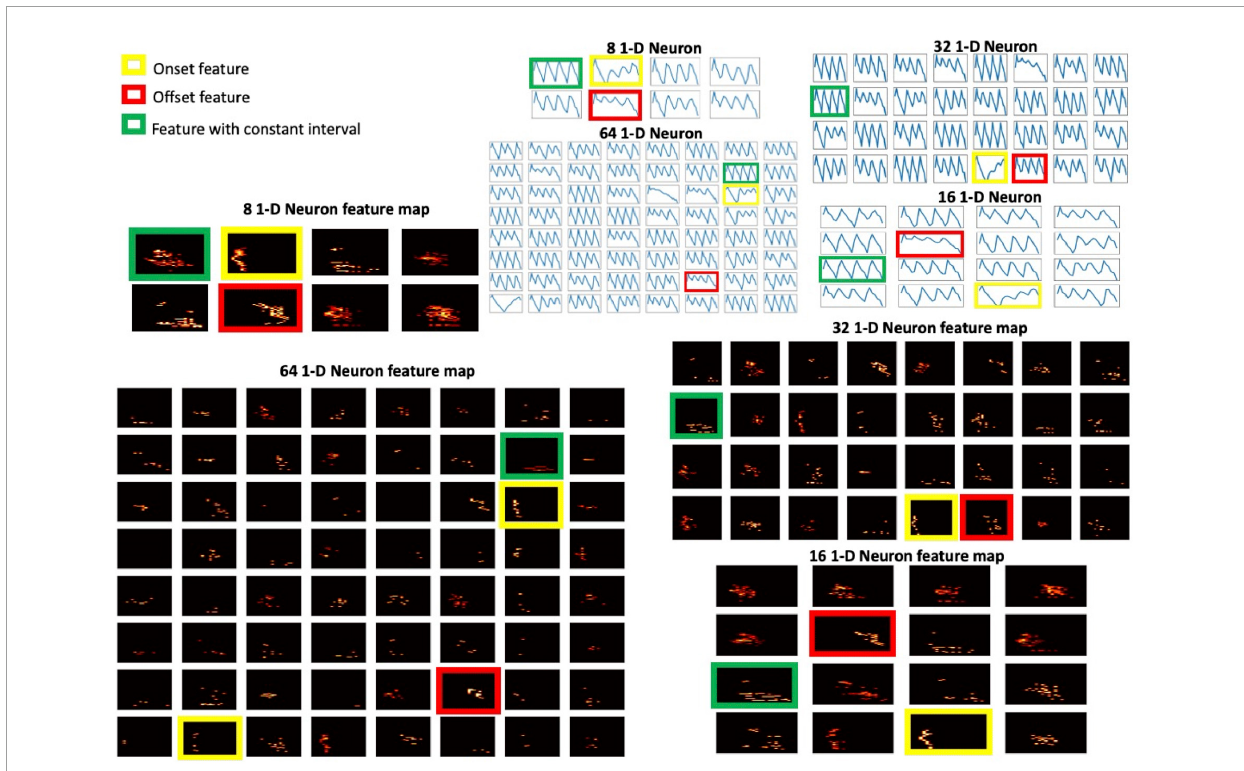
FIGURE6 The 1-D neuron features with different configurations and the corresponding feature